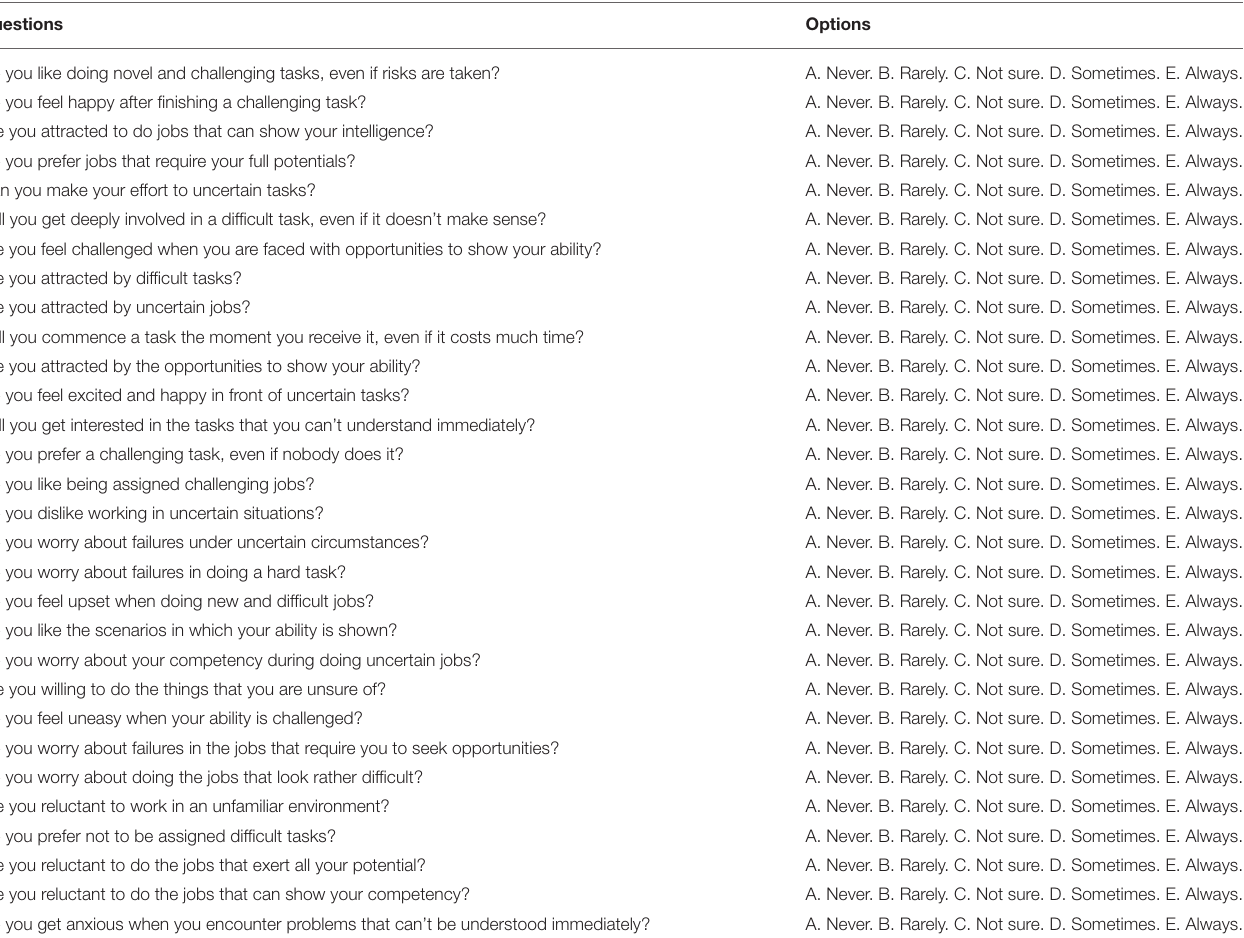
TABLE 5 | The success motivation